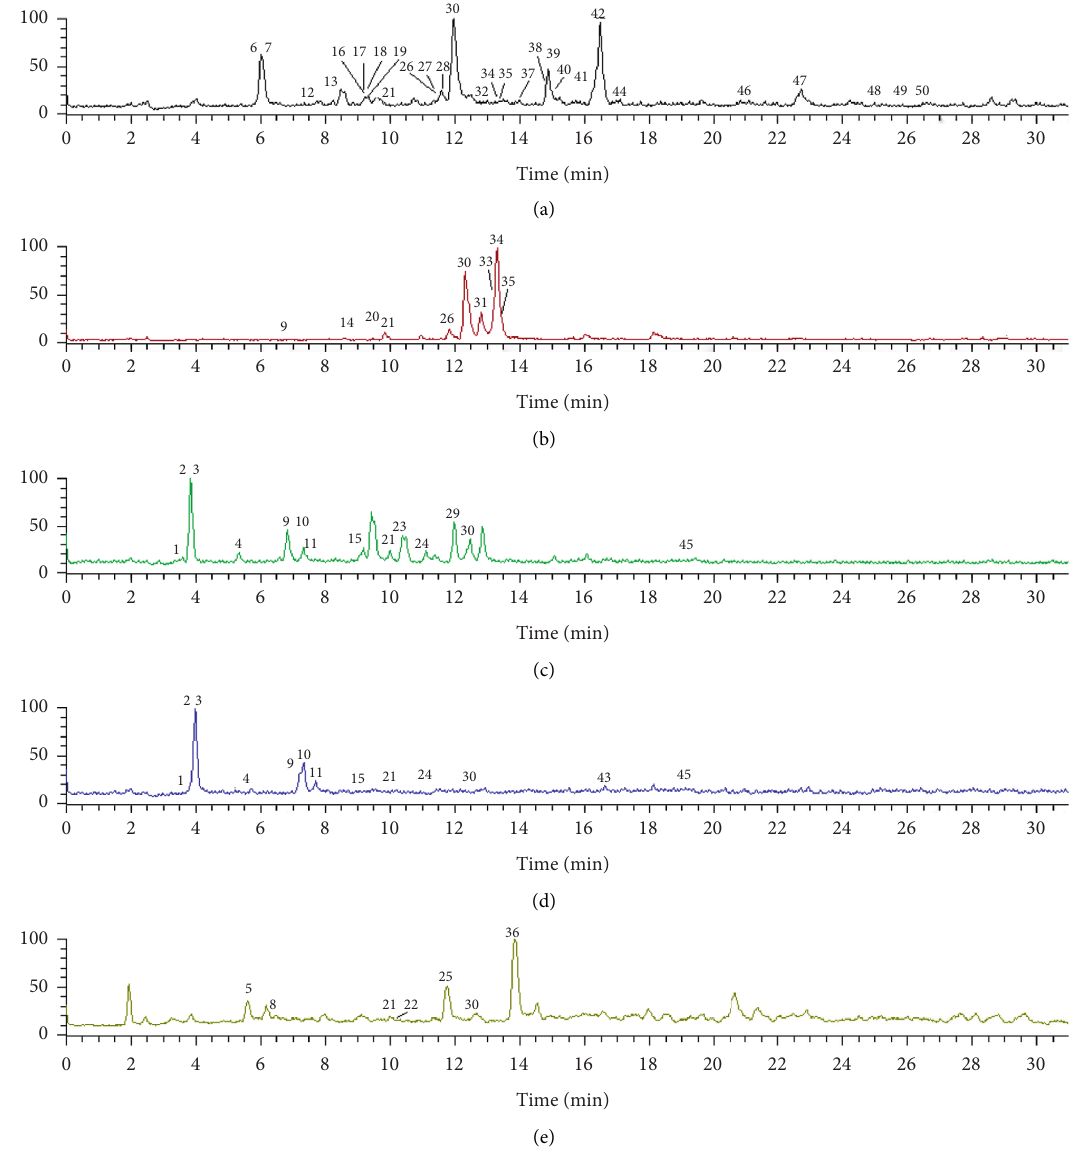
Figure 2: Total ion chromatograms (TIC) of Senecio nemorensis (a), Senecio vulgaris (b), Senecio cannabifolius (c), Senecio cannabifolius var. integrifolius (d), and Senecio scandens (e). For peak assignment, see Table